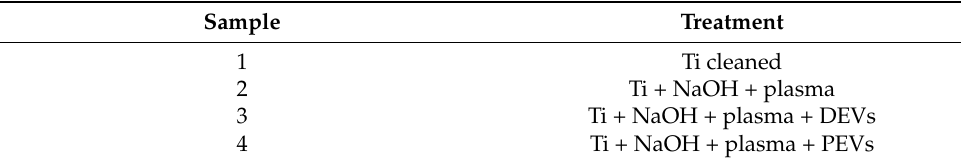
Table 1. Groups for FTIR analysis.